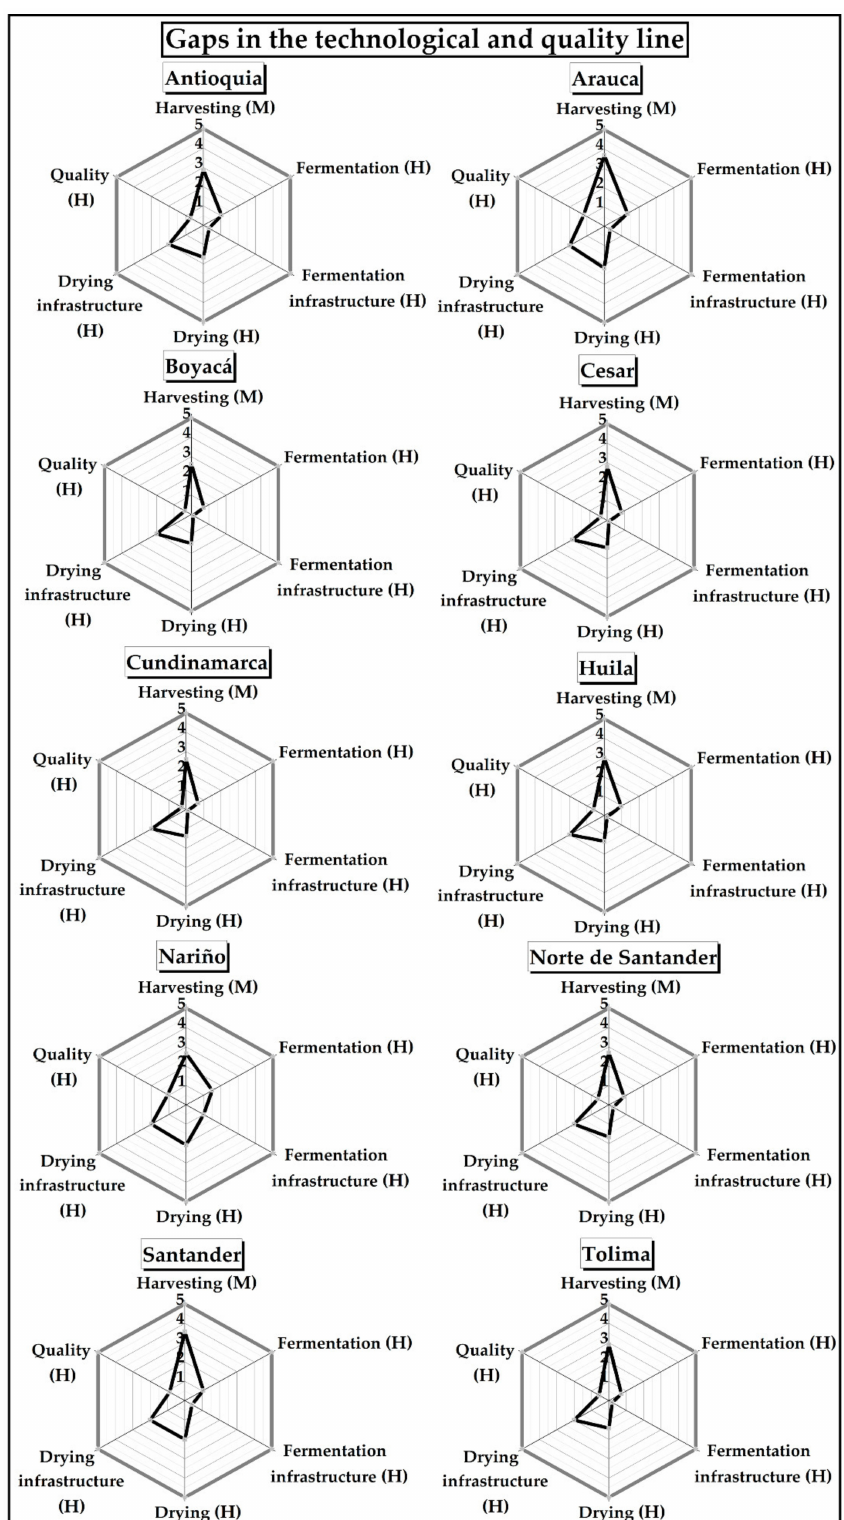
Figure 9. Main gaps identified in the technological and quality strategic line by region: Current situation, represented by a black line, versus best practice / scenario, represented by a gray line. Next to each variable, the qualitative assessment of the gap is indicated in parentheses: high (H), medium (M), or low